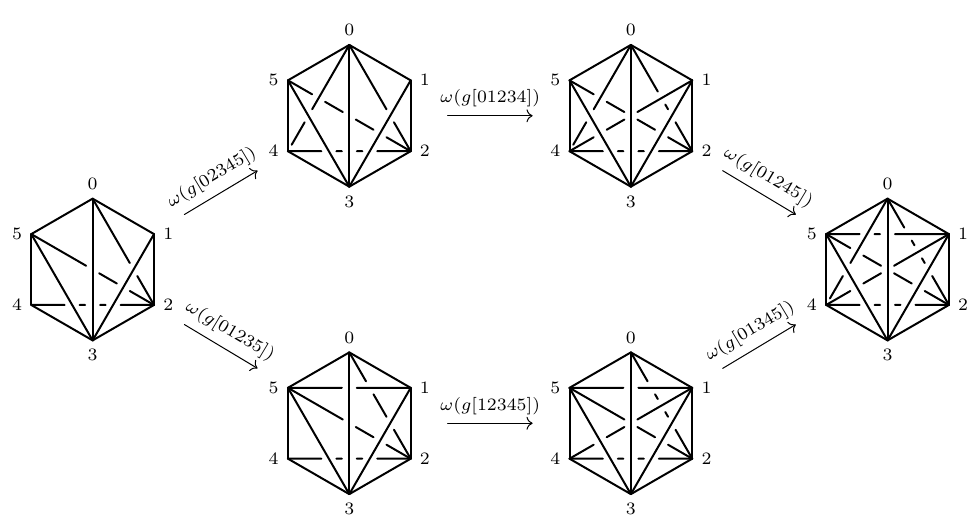
Figure 1 . Coherence relation of the 2 (cid:11) 3 Pachner moves. Given a complex obtained as the gluing of three 3-simplices, two di(cid:11)erent sequences of 2 (cid:11) 3 Pachner moves result in the same complex obtained as the gluing of six 3-simplices. Each arrow is decorated by the amplitude of the corresponding move obtained as the evaluation of ! on the 4-simplex whose boundary provides the 3-simplices involved in the corresponding 2 (cid:11) 3 move. This coherence relation is satis(cid:12)ed if ! is a